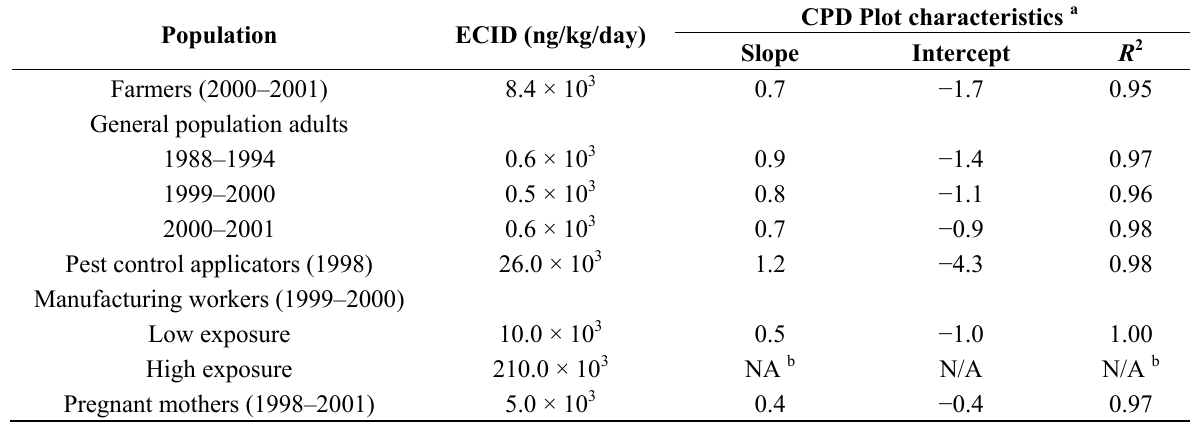
Table 2. Overview of the ECID in various USA populations at 0.95 Cumulative Probability